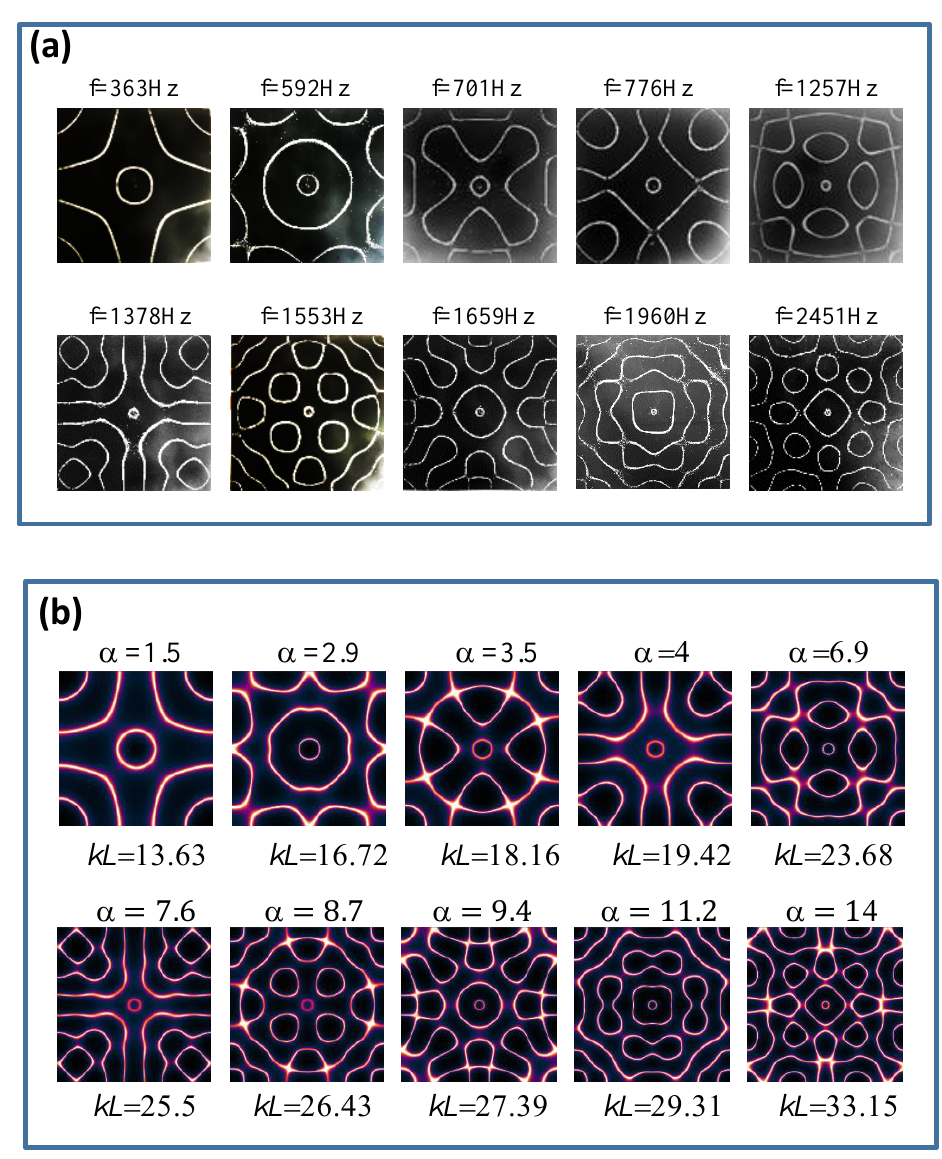
L L  r (on the center). s